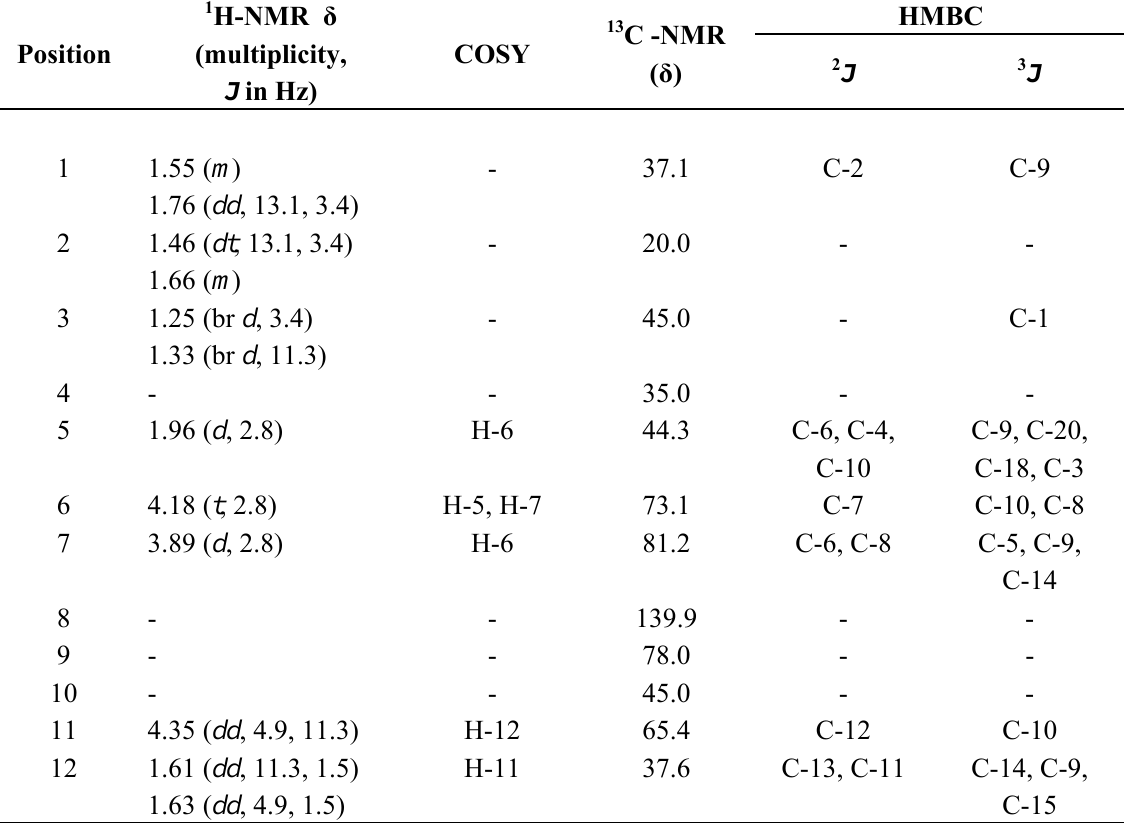
Table 1. 1 H-NMR (500 MHz) and 13 C-NMR (125 MHz) spectral data of kaempfolienol ( 1 ) (CD 3